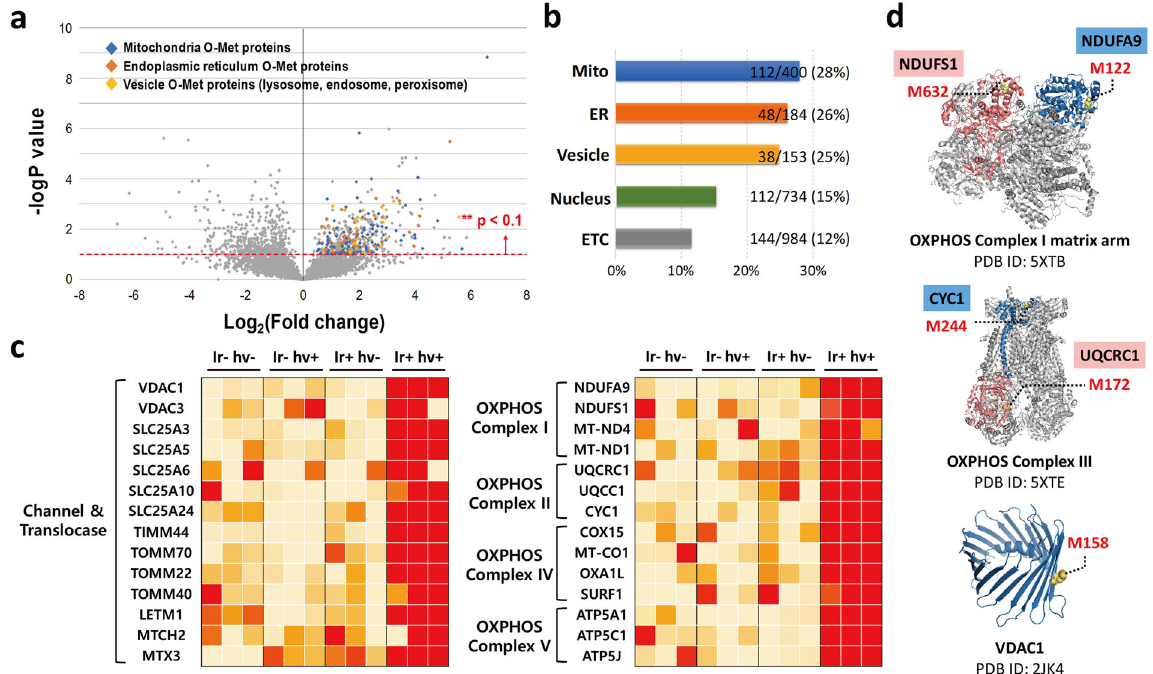
Fig. 6 Mitochondrial depolarisation related proteomics. a Quantitatively analysed Volcano plot of oxidised proteome. The substantially oxidised proteome was sorted in the range of log 2 (Fold change) > 0 and – log P value > 1 (light blue region). b Proportion of the oxidised proteome in various organelles. Proteome location was determined using UniProt and mitochondria proteins were cross-checked with Human MitoCarta2.0 dataset consisting of 1158 human genes. The proportion (%) was obtained as ratio between the number of signi fi cantly oxidised proteome ( − log P > 1) and that of whole oxidised proteome ( − log P > 0) in each cell organelle. c Heat map with label free quanti fi cation (LFQ) values for 28 mitochondrial proteins among 112 substantially oxidised mitochondrial proteins (Supplementary Data). d Three representative oxidised proteins; OXPHOS complex I (NDUFS1 and NDUFA9), OXPHOS complex III, and voltage-dependent anion-selective channel 1 (VDAC1). The crystal structures of three proteins from RCSB protein data bank (PBD ID) were visualised and processed with